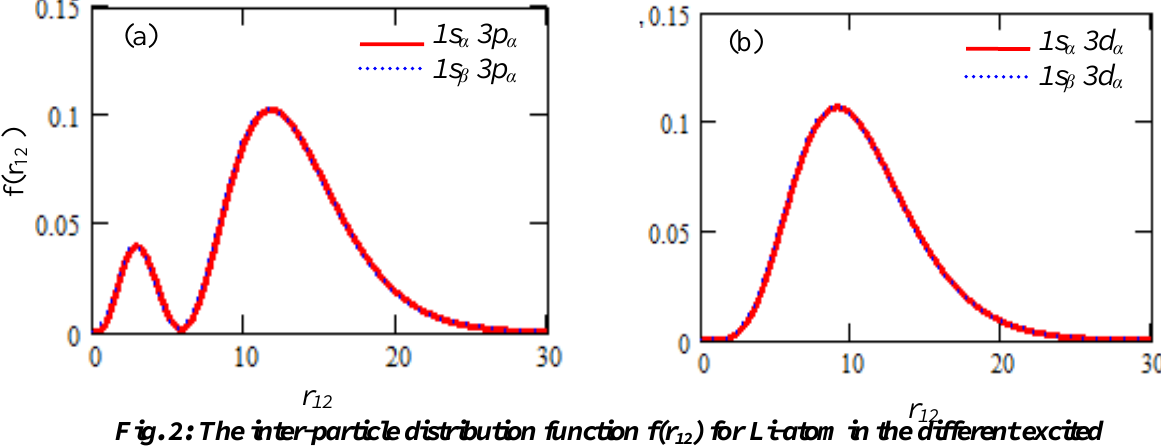
Fig. 2: The inter-particle distribution function f(r